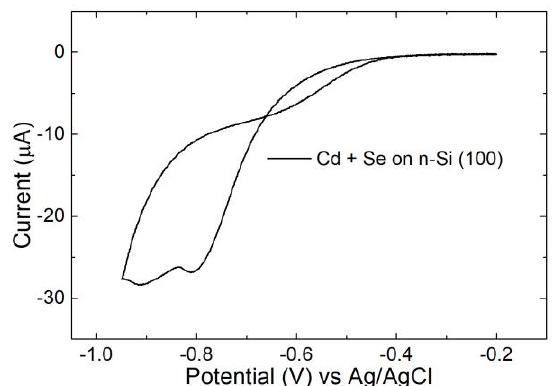
Figure 6. CV of Cd 2+ and Se(IV) solution on n-Si in sulfuric acid between −0.2 V to −0.95 V, scan rate 10 mV/s.